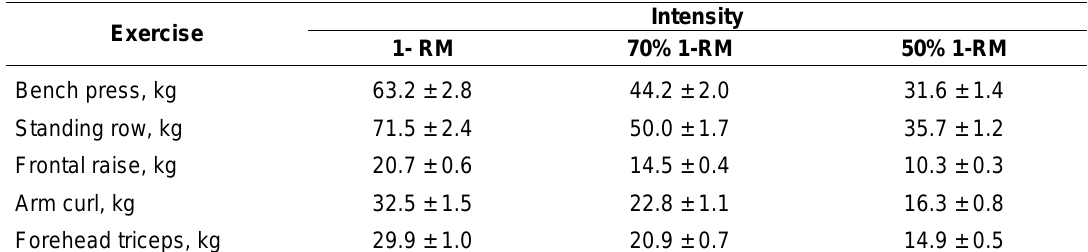
Table 2. Resistance exercise load at different